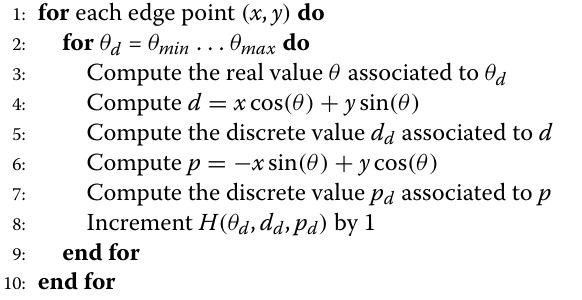
Algorithm 1 First stage of the voting process